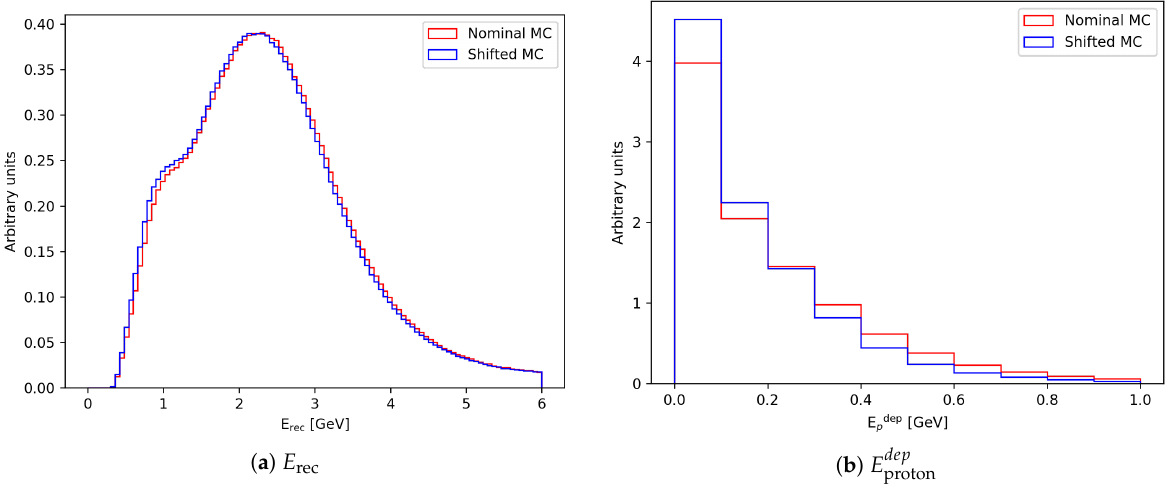
Figure 92. Effect of scaling energy deposits due to protons down by 20% on the E rec ( a ) and E dep